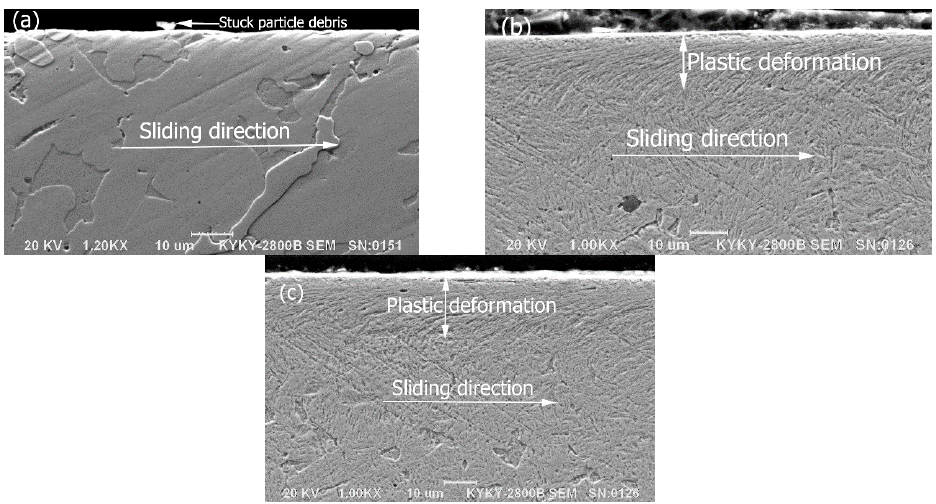
Figure 11. SEM micrographs showing subsurface morphologies of the Mo–40Ni–13Si intermetallic alloy ( a ); the hardened 0.45%C steel ( b ); and austenitic 1Cr18Ni9Ti stainless steel ( c ).